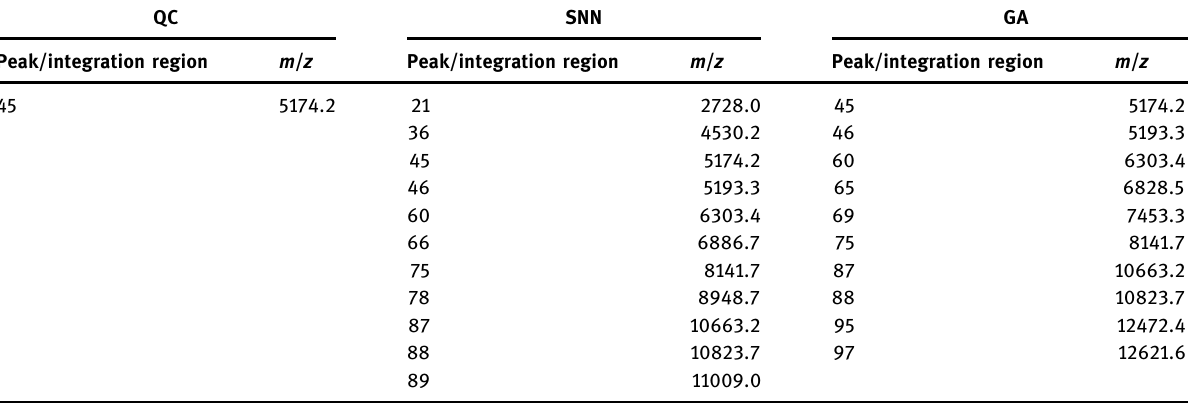
Table 3: Combinations of peaks ( m / z ) included in the generated classi fi cation models QC SNN GA Peak/integration